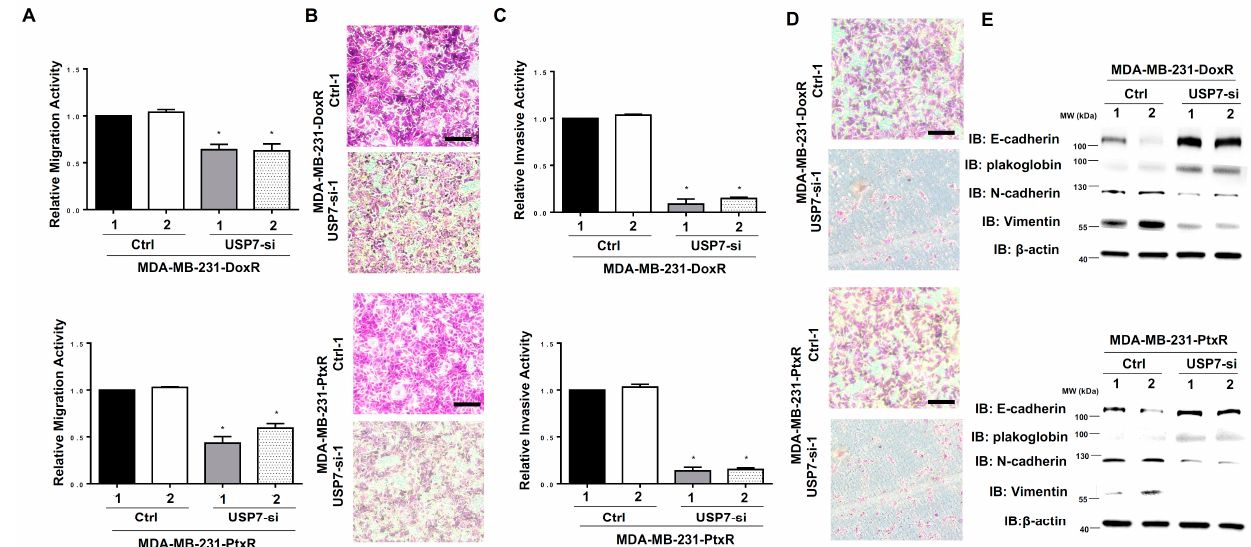
Figure 4. Effect of USP7 suppression on the metastasis of chemoresistant TNBC. ( A ) Relative migration activity of MDA-MB-231-DoxR-USP7-silencing (upper) and MDA-MB-231-PtxR-USP7-silencing (lower) cells, by using in vitro Transwell-dependent migration assays. ( B ) Images for migration activity of MDA-MB-231-DoxR (upper) and MDA-MB-231-PtxR (lower) cells with USP7 suppression with steady concentration of doxorubicin and paclitaxel, respectively. ( C ) Relative invasive activity of MDA-MB-231-DoxR-USP7-silencing (upper) and MDA-MB-231-PtxR-USP7-silencing (lower) cells, using in vitro Transwell-dependent invasive assays. ( D ) Images for the invasive activity of MDA-MB-231-DoxR (upper) and MDA-MB-231-PtxR (lower) cells with USP7 suppression with steady concentration of doxorubicin and paclitaxel, respectively. ( E ) Expression levels of the EMT markers in MDA-MB-231-DoxR-USP7-silencing (upper) and MDA-MB-231-PtxR-USP7-silencing (lower) cells, by western blot analysis with specific antibodies. Data are represented as the mean ± SEM for biological triplicate experiments. * p < 0.05, compared with the results for MDA-MB-231-DoxR-Ctrl-1 and MDA-MB-231-PtxR-Ctrl-1 cells, respectively.